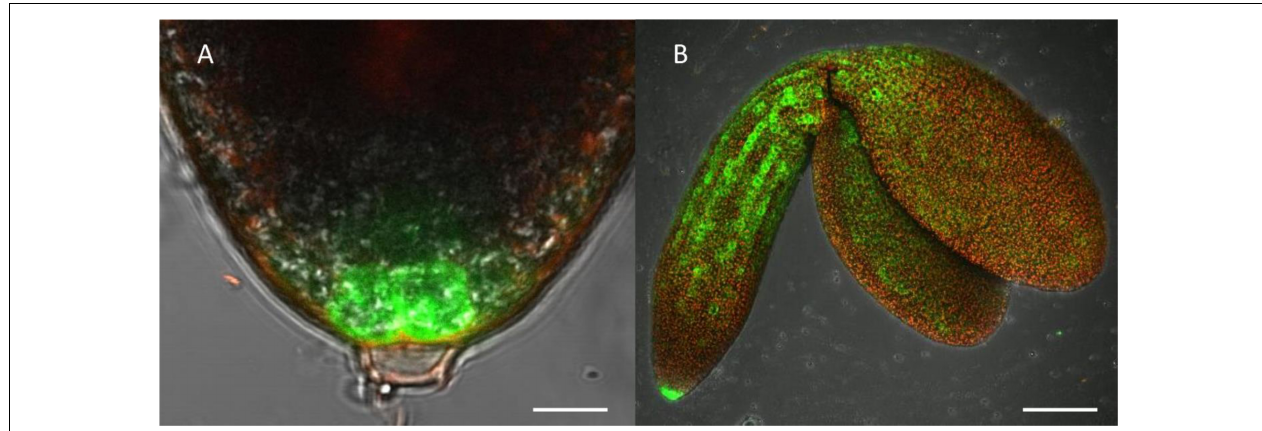
FIGURE 4 | Highlight of CTPS2::GFP fluorescence imaging. Embryos were isolated from siliques 8 days after fertilization (DAF) for confocal laser scanning microscopy. For this, lines CTPS2::GFP #10 and #15 were used and typical images were selected. Scale bar = 10 µ m in (A) and 100 µ m in (B) . Maximum projection of 24 pictures in (B)